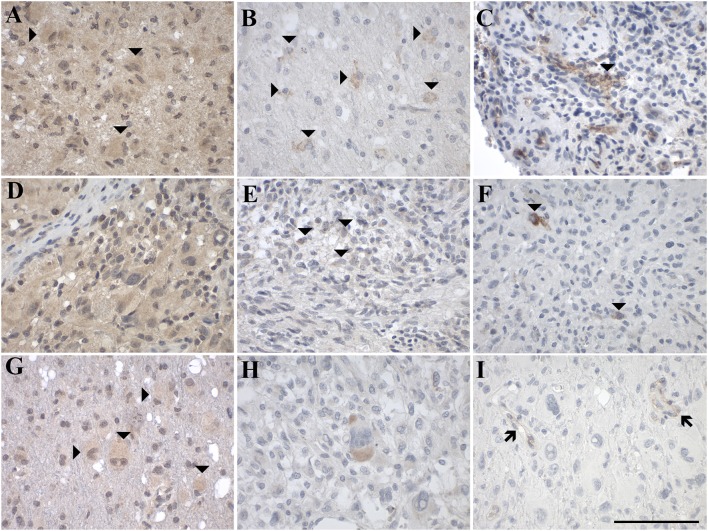
Representative images of immunohistochemical staining of high-grade astrocytic tumors with (A–C) glioblastoma multiforme (WHO grade IV; case 18, 17, 20), (D–F) gliosarcoma (WHO grade IV; case 27, 25, 27), and (G–I) giant cell glioblastoma (WHO grade IV; case 31, 30, 31). GAL immunoreactivity is shown in (A,D,G); GAL1-R immunoreactivity in (B,E,H), and GAL3-R immunoreactivity in (C,F,I). Arrow heads indicate positive-stained cells whereas the arrows point out GAL3-R-positive blood vessels. [scale bar: 100 μm].